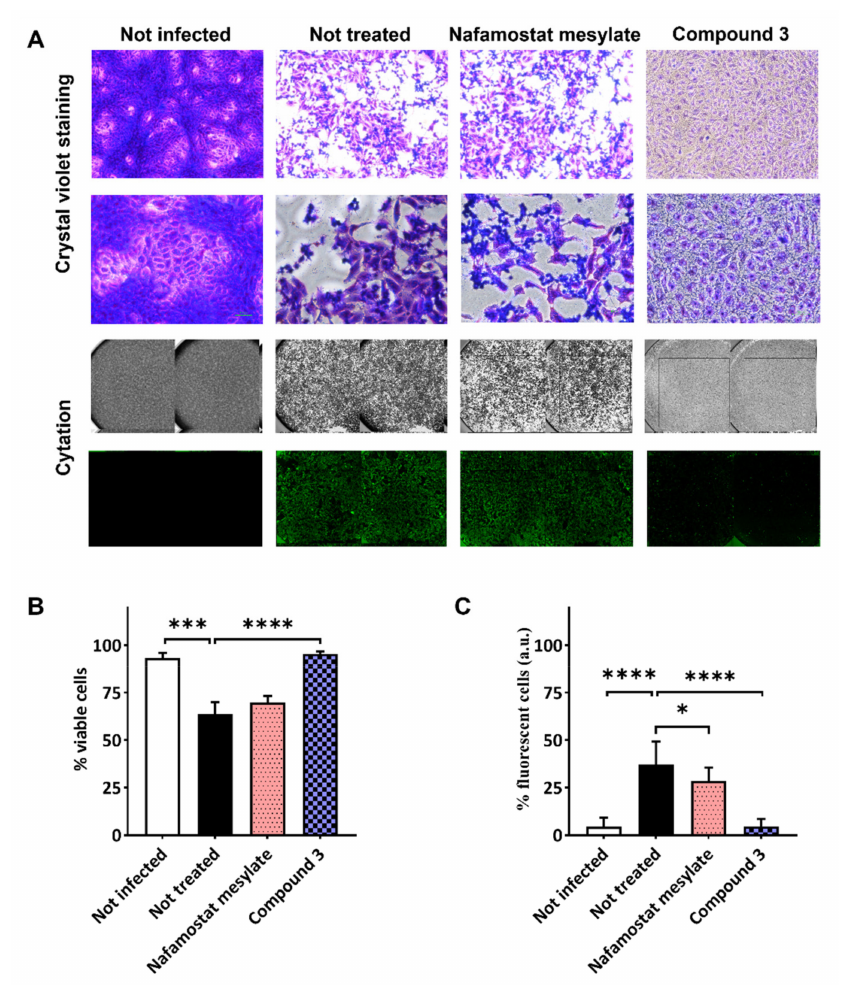
Figure 5. SARS-CoV-2 infection assay in VERO cells after treatment with nafamostat mesylate and compound 3 . VERO cells were treated with the test compounds diluted in cell culture medium at final concentration of 100 µ M. Two hours later, cells were washed and infected with SARS-CoV-2 clinical isolate. Untreated cells were used as infection control. Cells were monitored daily until monolayer was fixed before staining with crystal violet or immunofluorescence. Cytation instrument was used to acquire images of each well. ( A ) Representative images of crystal violet staining (10 × and 20 × in the first and second lanes, respectively) and an example of images acquired by Cytation instrument in visible light to analyze cytopathic effect/cell viability (third lane), and in immunofluorescence to evaluate infected cells (fourth lane). Bar plots showing average and SD of repeated experiments following crystal violet staining ( B ) and immunofluorescence ( C ). Statistical significance was assessed by using nested one-way ANOVA comparison tests, followed by Dunnett’s correction, indicated according to p value as follows: * p < 0.05; *** p < 0.001; **** p <